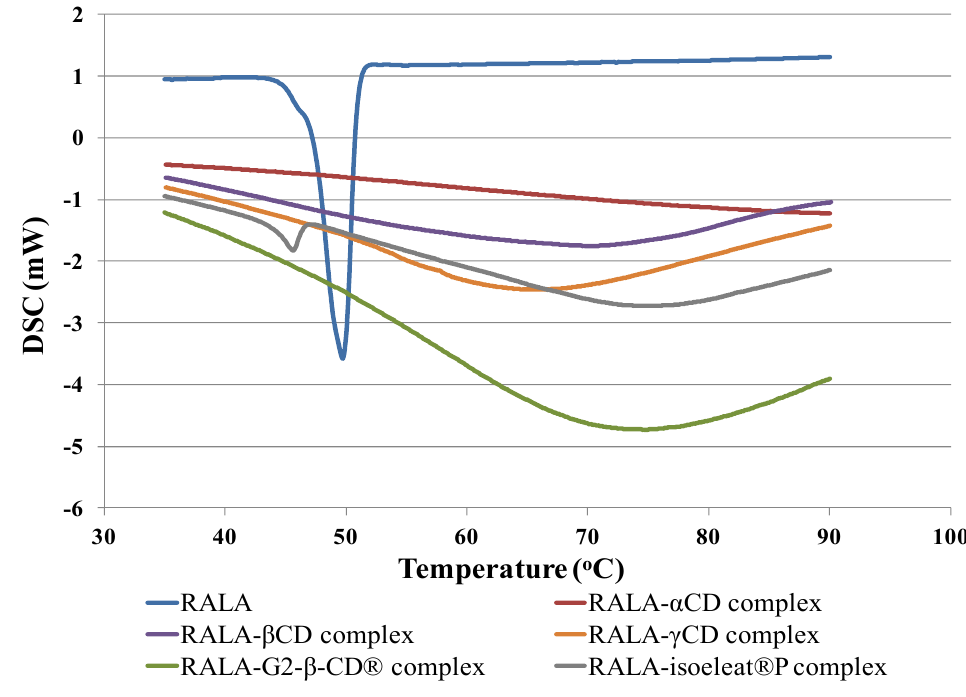
Figure 1. Differential scanning calorimetry (DSC) scans of R(+)-alpha lipoic acid (RALA) and RALA-cyclodextrin (CD) complexes. Samples were placed under the air flow for scanning and heating from 30 °C to 100 °C at 3